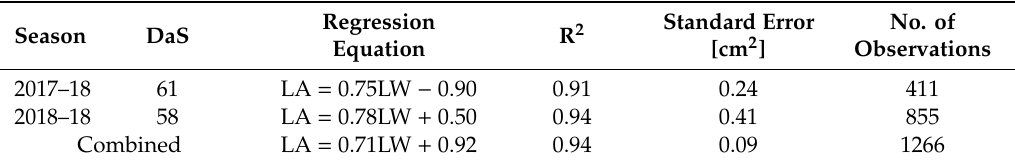
Table 3. Allometric relationships between L*W (product of length and maximum leaf width) and leaf area of individual wheat leaves